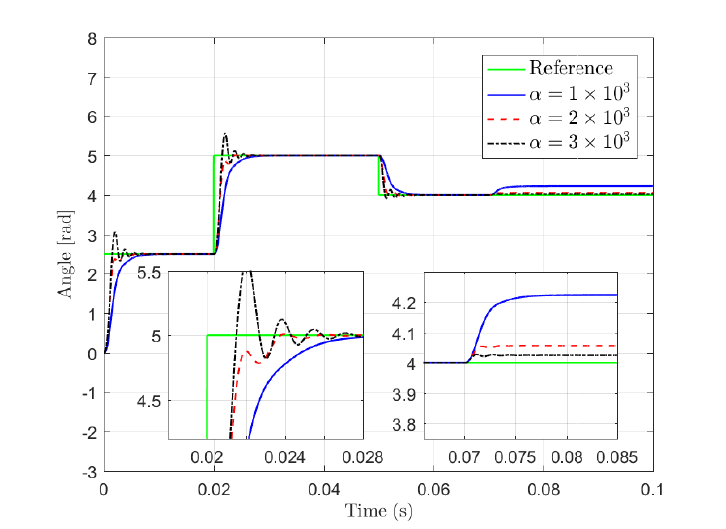
Figure 2. Transient and disturbance rejection performance of ROMBC